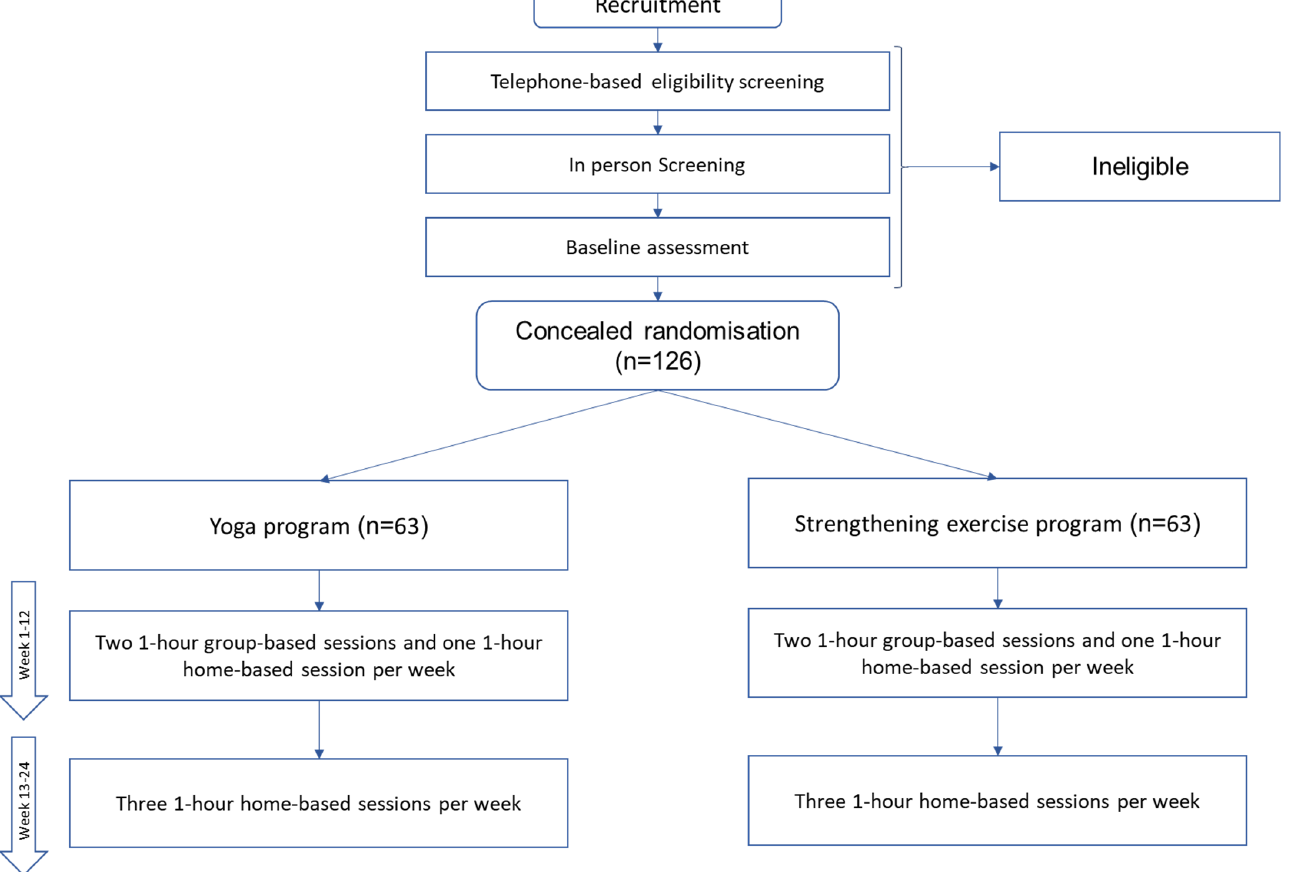
Figure 1. Trial Figure 1. Trial design.